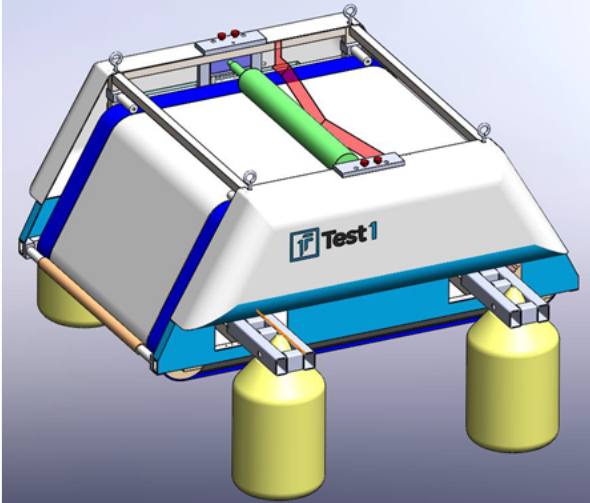
Figure 8. Preliminary design of one skimmer based on RMPUF